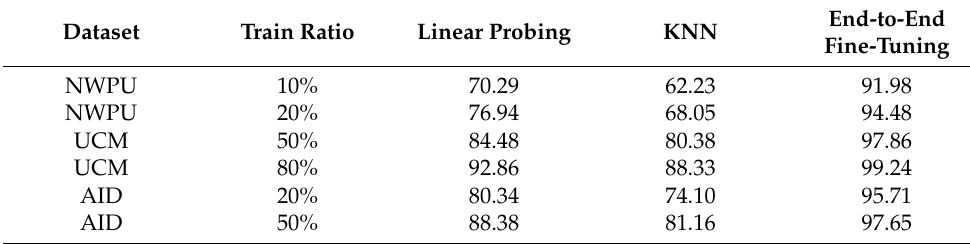
Table 3. Classification accuracy of three different transfer methods on three